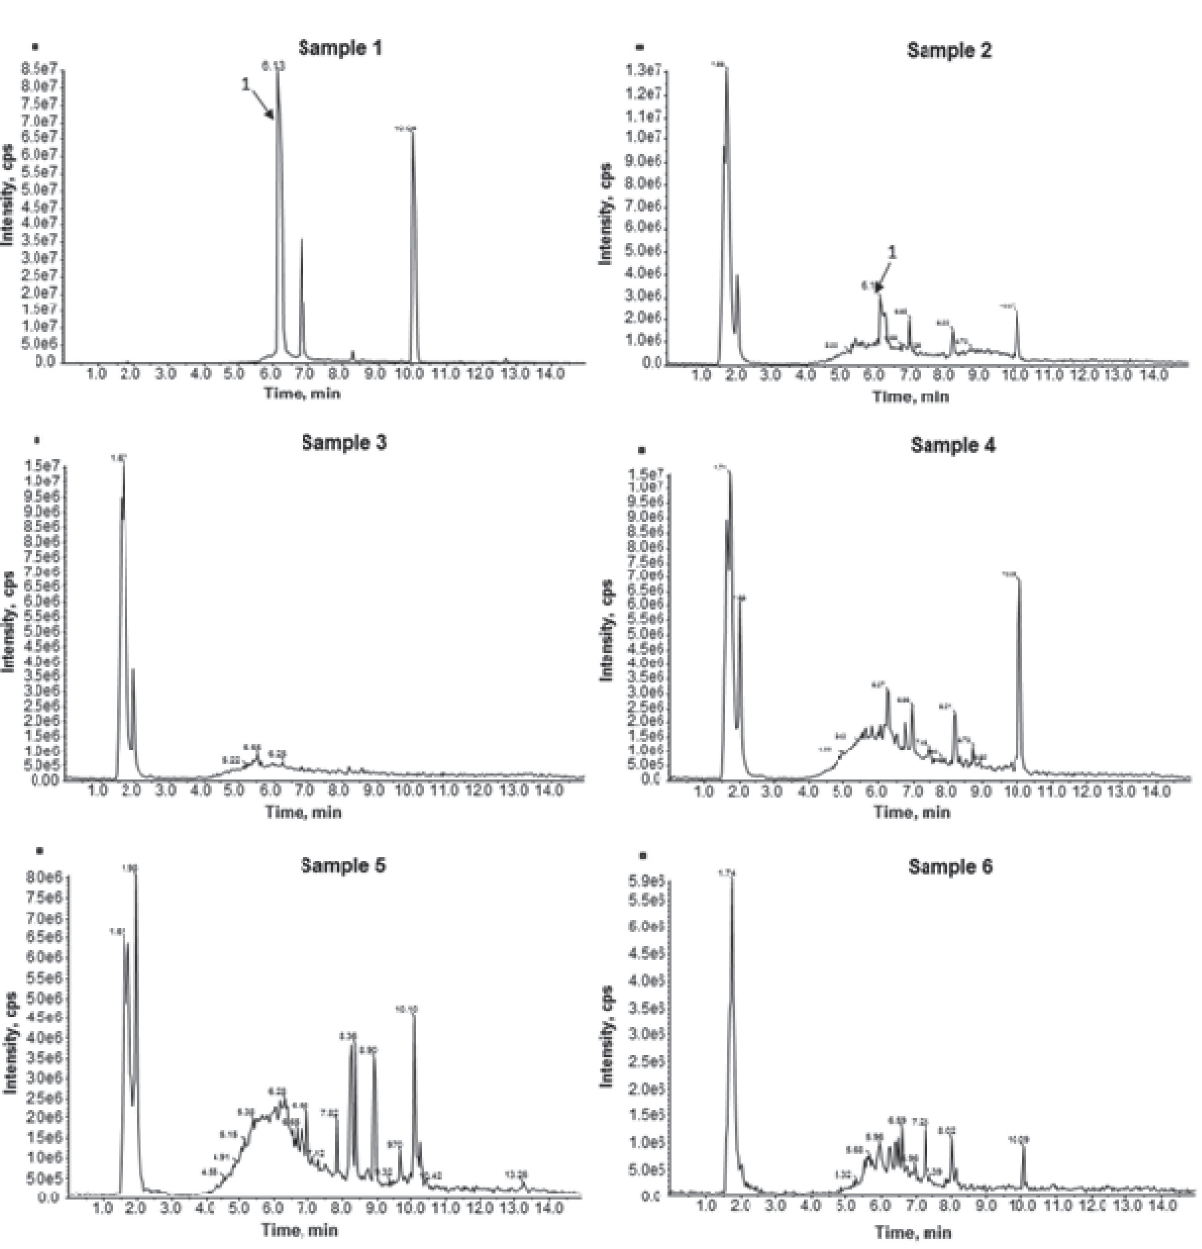
FIGURE 1 - Representative LC-MS profiles of commercially available aqueous extracts (Samples 1 to 5) of Tribulus terrestris and aqueous extract of the aerial parts of Tribulus terrestris (Sample 6). Peak 1 corresponds to